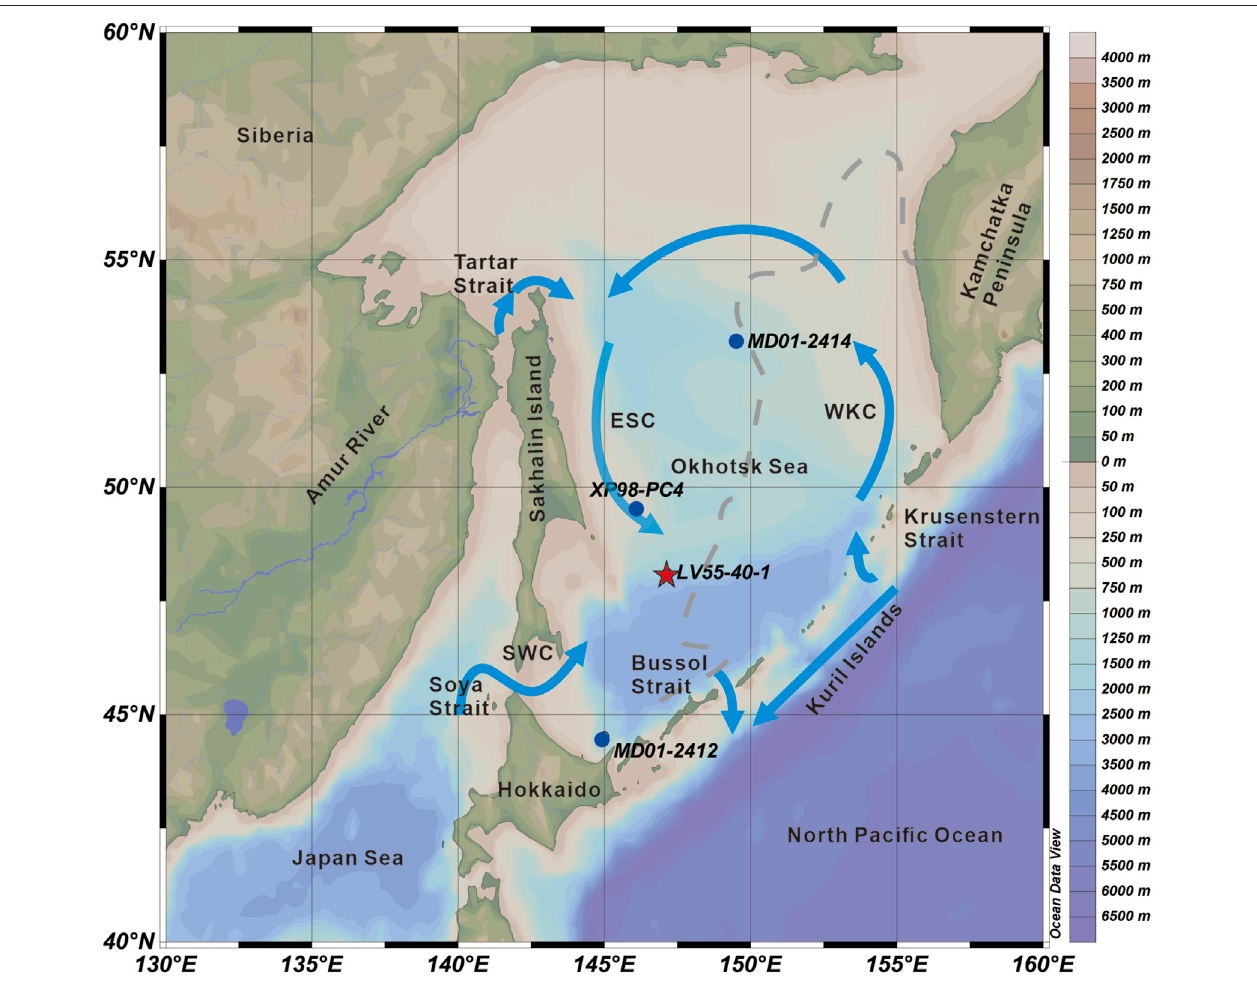
FIGURE 1 | Map of the Okhotsk Sea showing the locations of the core used in this study (LV55-40-1, red star) and other cores (blue dots) mentioned in the text (Sakamoto et al., 2006; Harada et al., 2008; Lo et al., 2018). Blue arrows indicate the East Sakhalin Current (ESC), West Kamchatka Current (WKC), and Soya Warm Current (SWC). The dashed line represents the average sea ice boundary from November to June according to Lo et al. (2018). Map generated using Ocean Data View version 4 (Schlitzer, 2021).